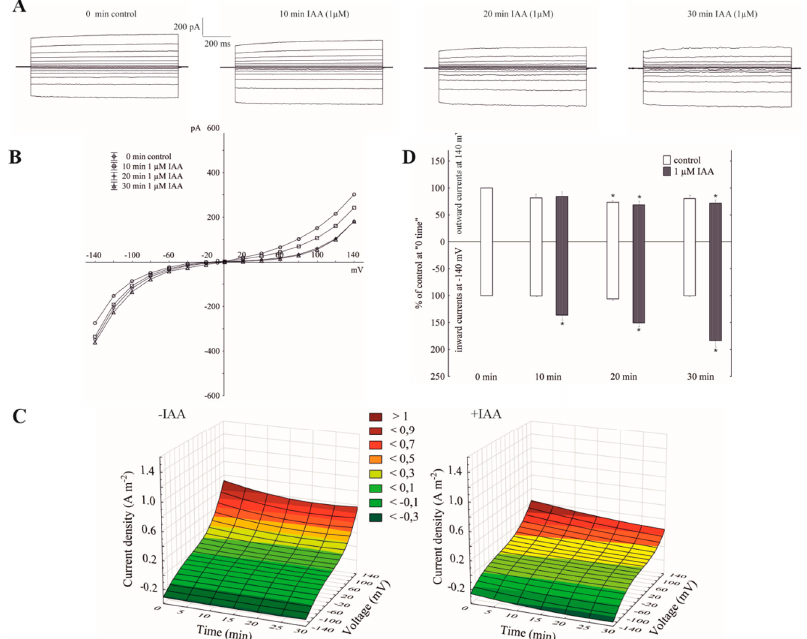
Figure 2. The amplitudes of the instantaneous vacuolar currents in the presence of cytosolic IAA and a ten-fold vacuole-to-cytosol KCl gradient. ( A ), An example of a whole-vacuole FV current recording in a 10/100 KCl gradient in the absence and presence of 1 µM IAA. The control at “0 time” (0 min control) means the whole-vacuole FV current was recorded immediately after establishing the whole- vacuole configuration in the ten-fold KCl gradient that was imposed on a vacuolar membrane; however, the current in the absence and presence of IAA was recorded 5, 10, 15, 20, 25 and 30 min later. For clarity, only the FV currents in the control (0 min control) and the presence of IAA after 10, 20 and 30 min were shown. ( B ), The instantaneous vacuolar currents shown as a function of voltage (the data are from the same experiment as shown in A). ( C ), The current–voltage relationships in the absence ( − IAA) and presence (+IAA) of 1 µM IAA shown as a function of time. Means of at least seven different vacuoles are shown. ( D ), The whole-vacuole FV currents recorded at − 140 and +140 mV in the presence of 1 µM IAA. The data were expressed as % of the control (0 min control). Means ± SE of at least six different vacuoles are shown. The normal distribution was evaluated by the Shapiro–Wilk test ( p > 0.05). The statistical differences between the control at 0 min and other variants at the same voltage were analyzed using a paired t -test ( p < 0.05). Asterisk (*) indicates significant difference.